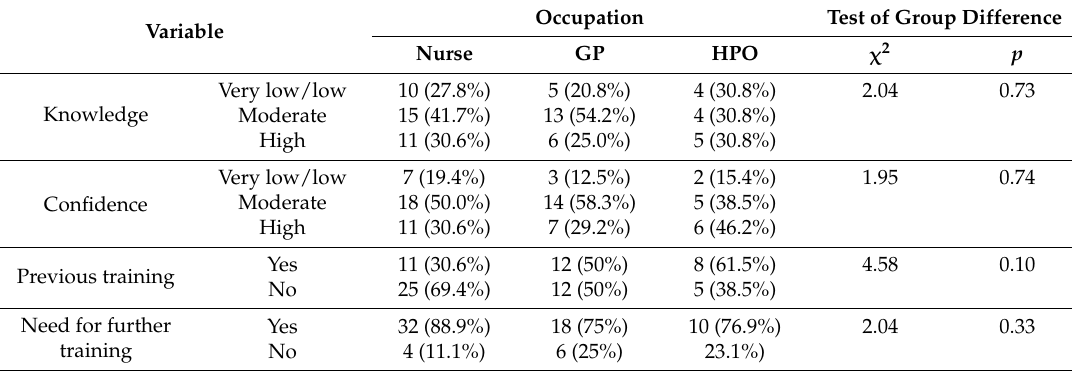
Table 2. HCP’s knowledge, confidence, training needs and experience with refugee and migrant women’s SRH